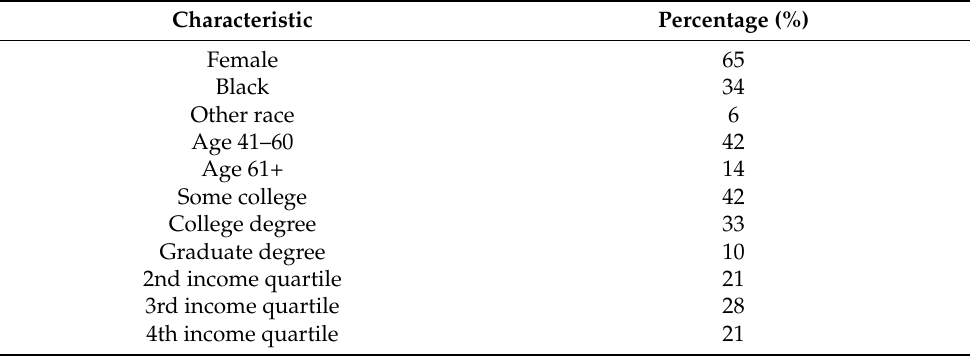
Figure 1. Sequence of events within each trial. Table 1. Descriptive statistics for our